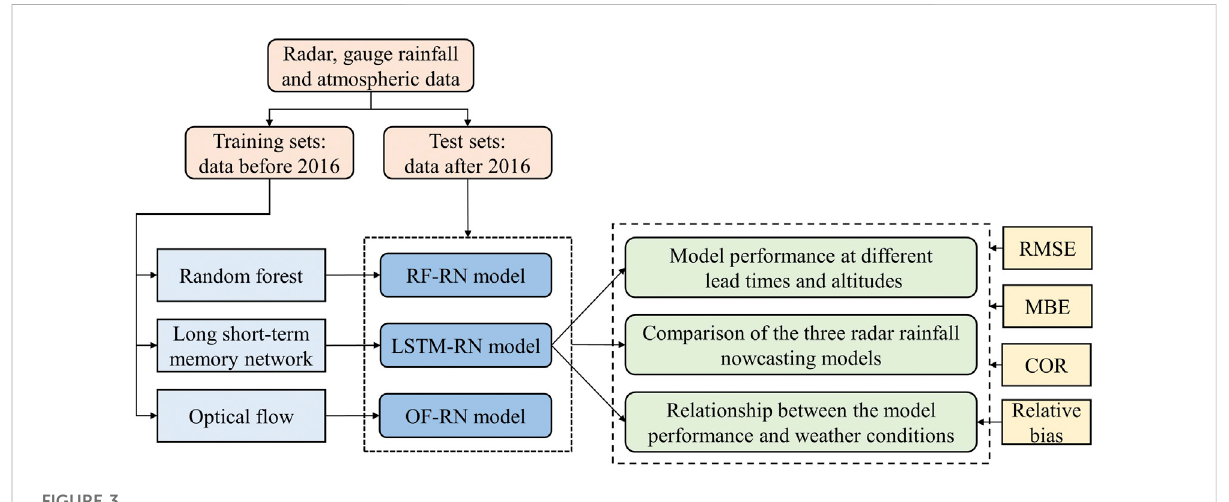
FIGURE 3 Schematic diagram of the experimental design.